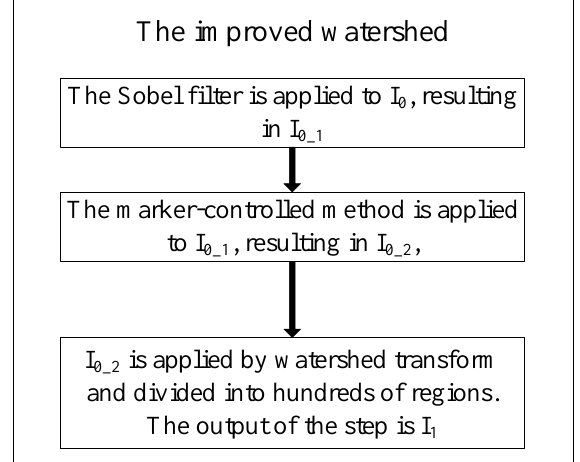
Fig 3. The procedures of the improved watershed transform.